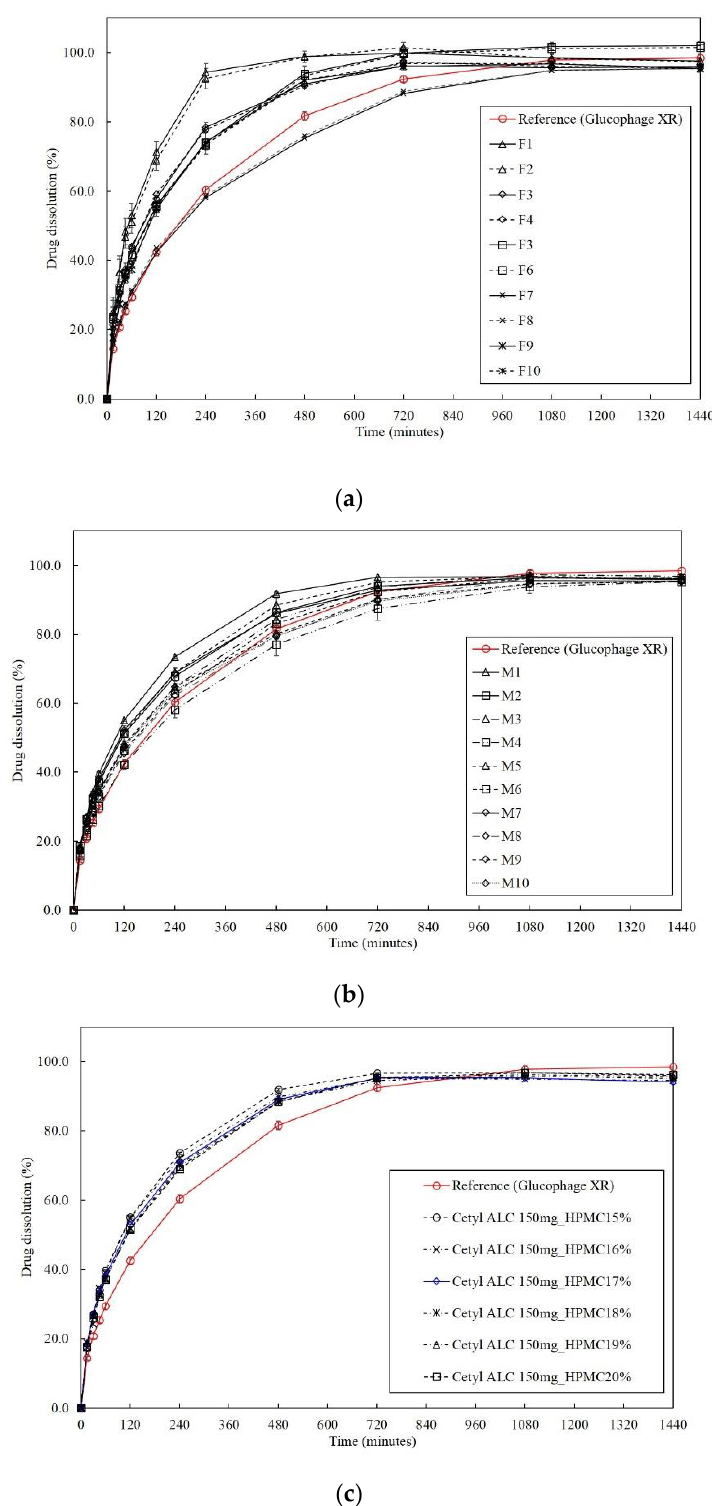
Figure 3. ( a ) Dissolution profiles for the two-level full factorial design (FFD); ( b ) dissolution profiles for the response surface method; ( c ) dissolution profiles for the optimized formulations including the dissolution profile of Glucophage XR as the reference